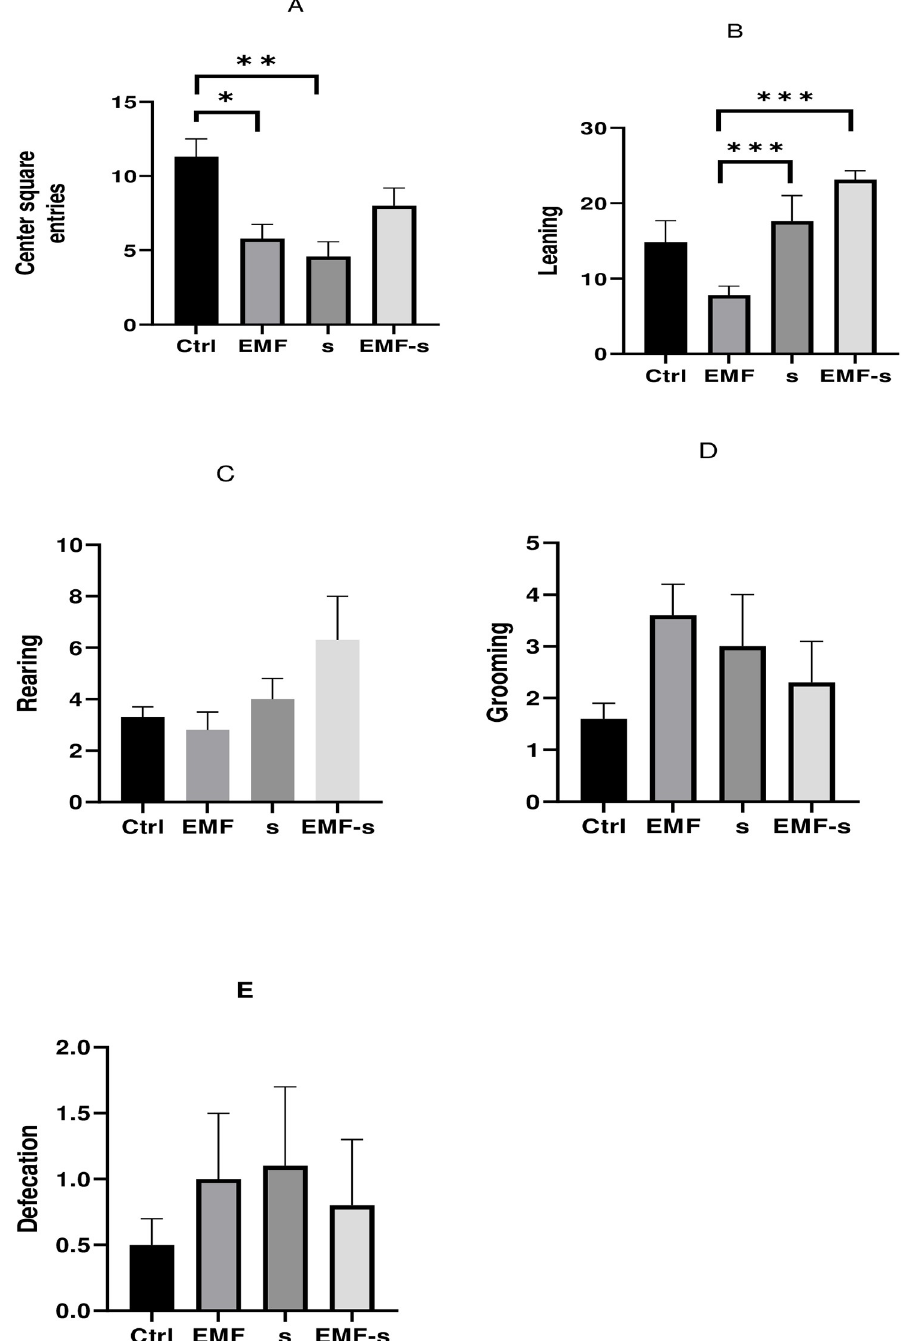
Fig 6. Effect of EMF on Center square entries (A), Leaning (B), Rearing (C), Grooming (D), Defecation (E), after prenatal stress. Data are shown as mean ± SEM (n = 6 per group). Two-way ANOVA, followed by Tukey’s posthoc test: � p < 0.05, �� p < 0.01, ��� P < 0.001, ANOVA, analysis of variance; Ctrl, Control; EMF, Electromagnetic Field; Stress, Prenatal stress.